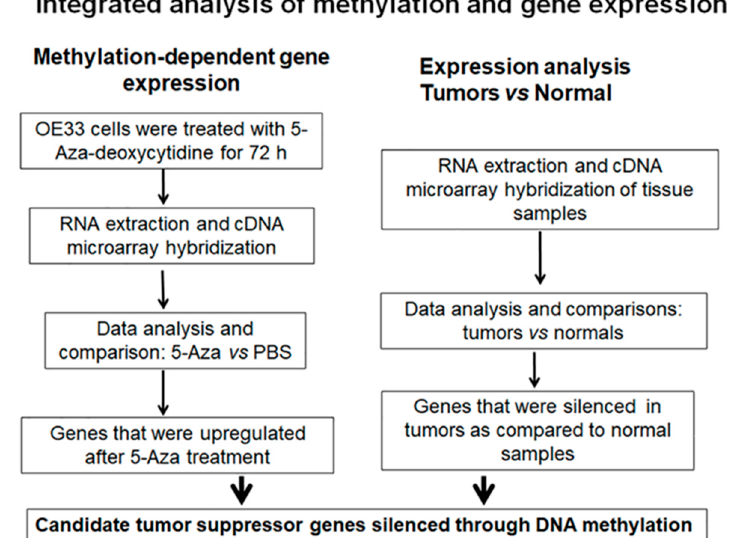
Figure 1. Experimental flow chart for screening functional epigenetic markers.